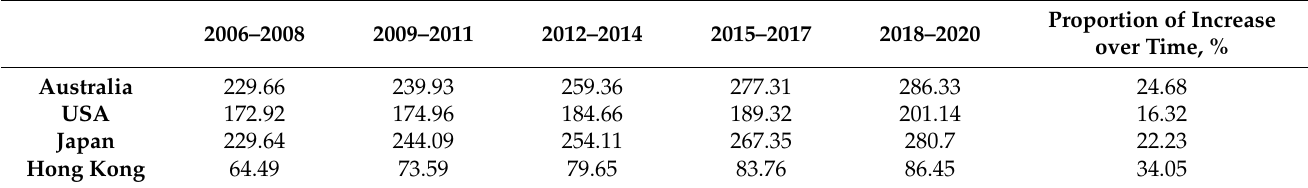
Table 1. Total sales per capita of savoury snacks over three-year periods and proportion of increase from 2006 to 2020 in Australia, the USA, Japan, and Hong Kong.